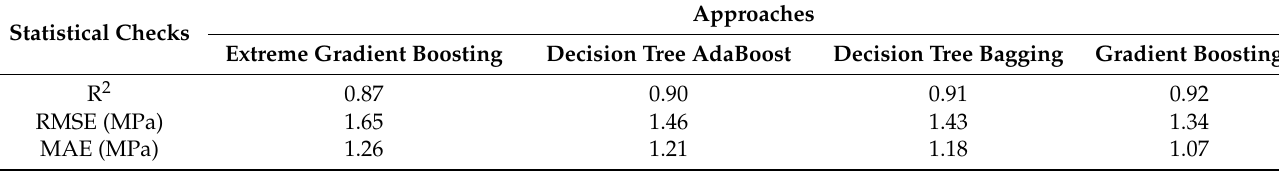
Table 1. Extreme gradient boosting, bagging, and AdaBoost model statistical checks.